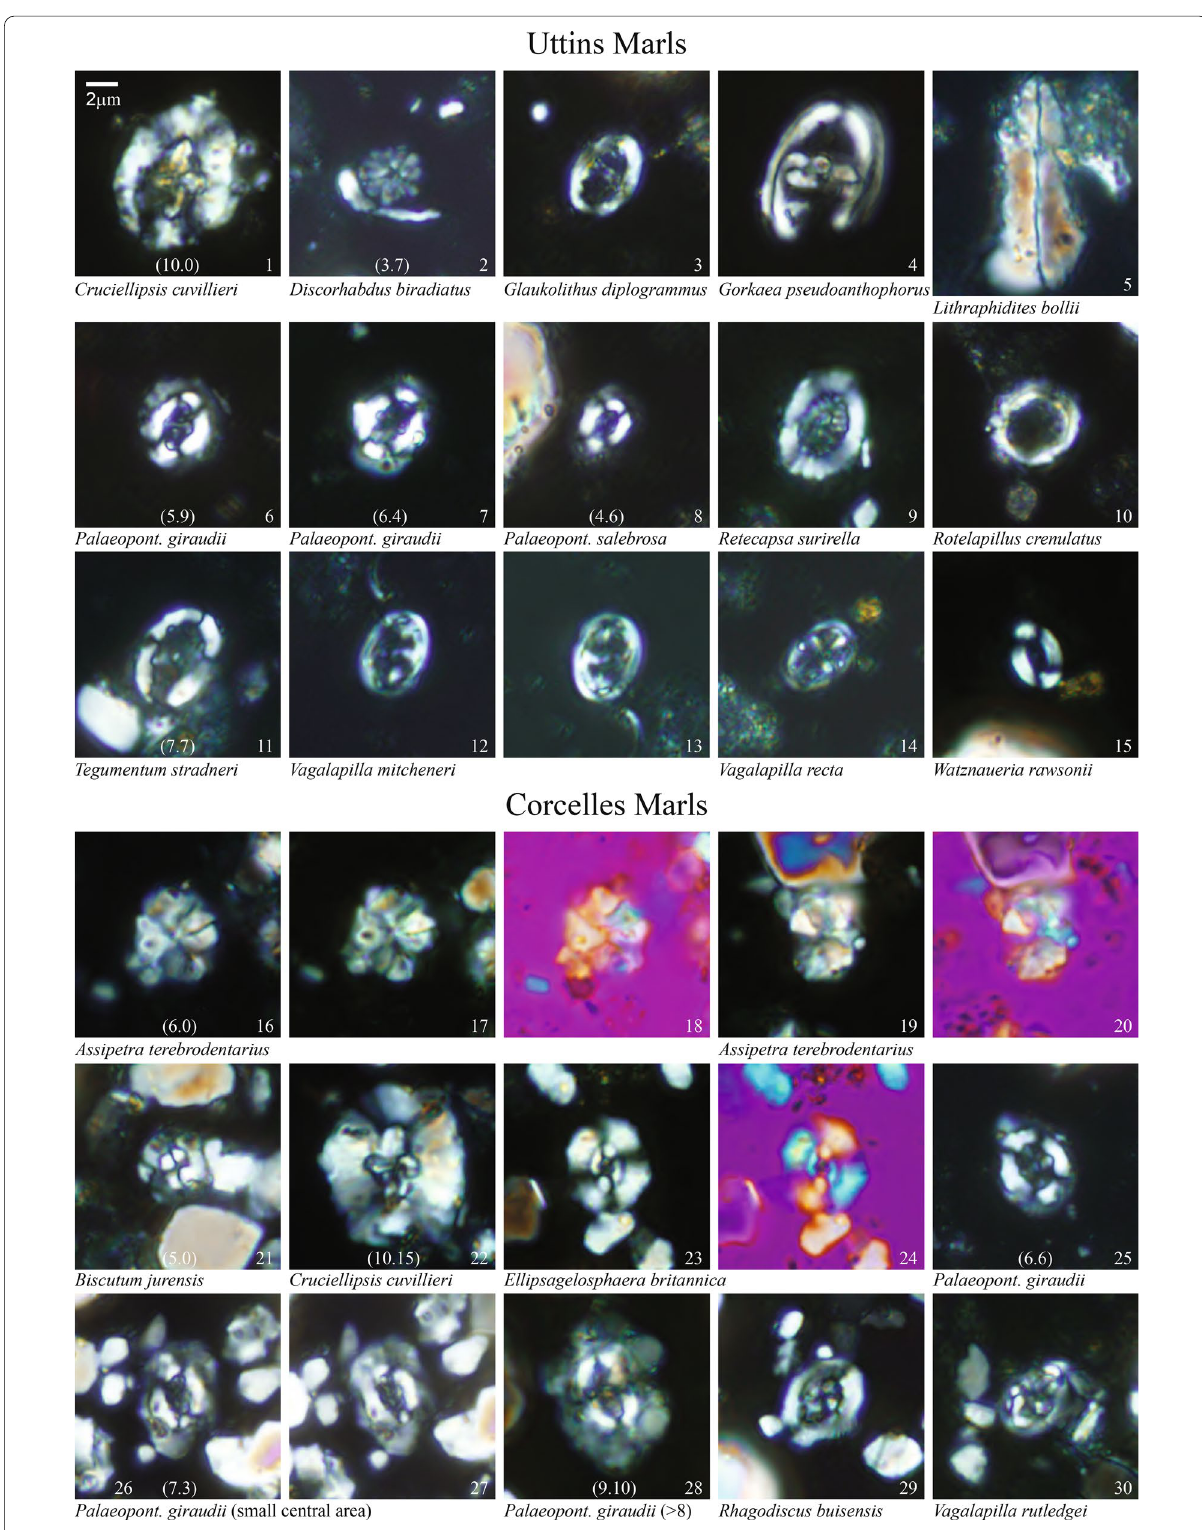
Fig. 13 Calcareous nannofossils from the late Early Hauterivian Uttins Marls (sample from the Mont de Chamblon section, VD) and Early Barremian Corcelles Marls (sample from the Corcelles‑2 section, NE), collection E. De